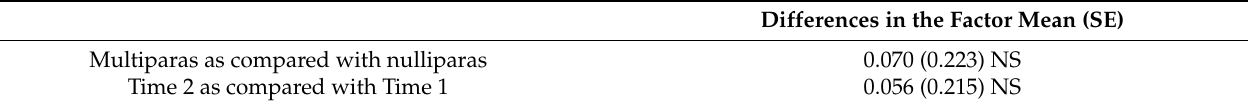
Table 3. Factor mean invariance of the